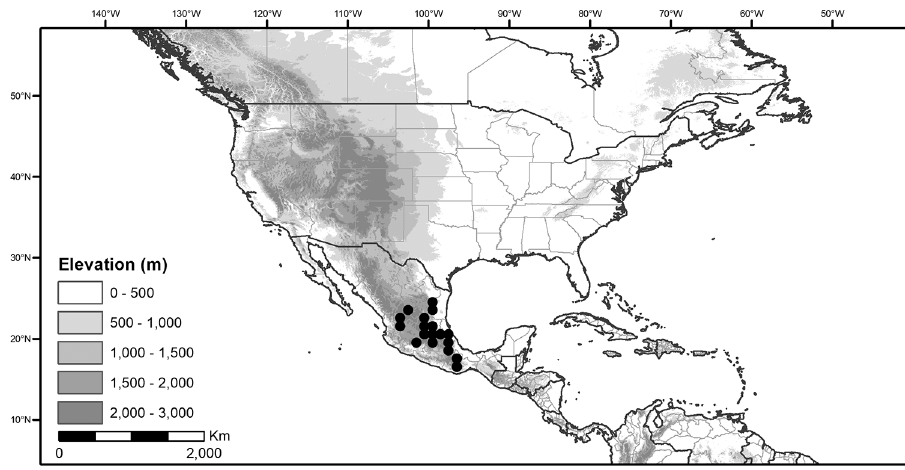
Figure 38. Distribution of Solanum pruinosum